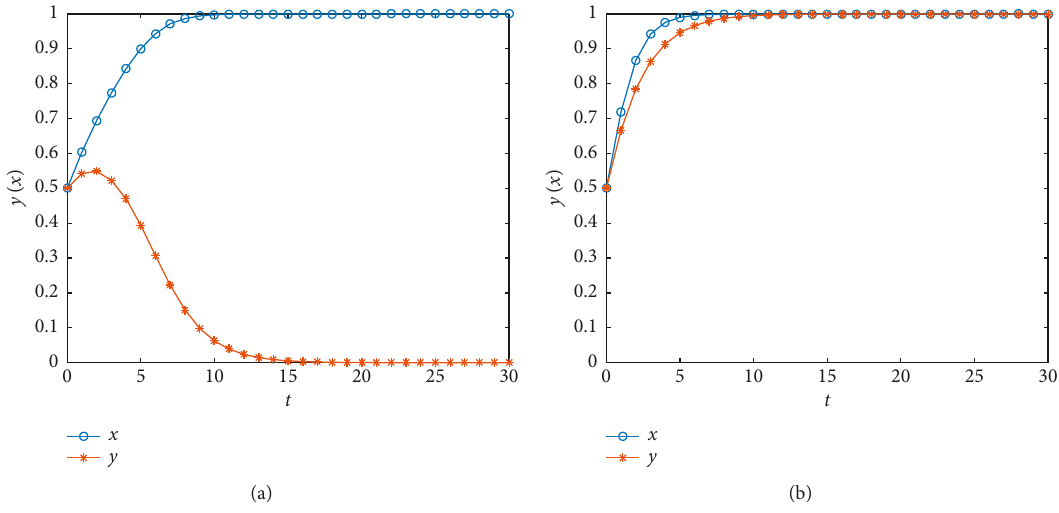
Figure 9: Influences of government penalty P on the evolutionary results. (a) P � 0 . 5. (b) P � 1 . 5.